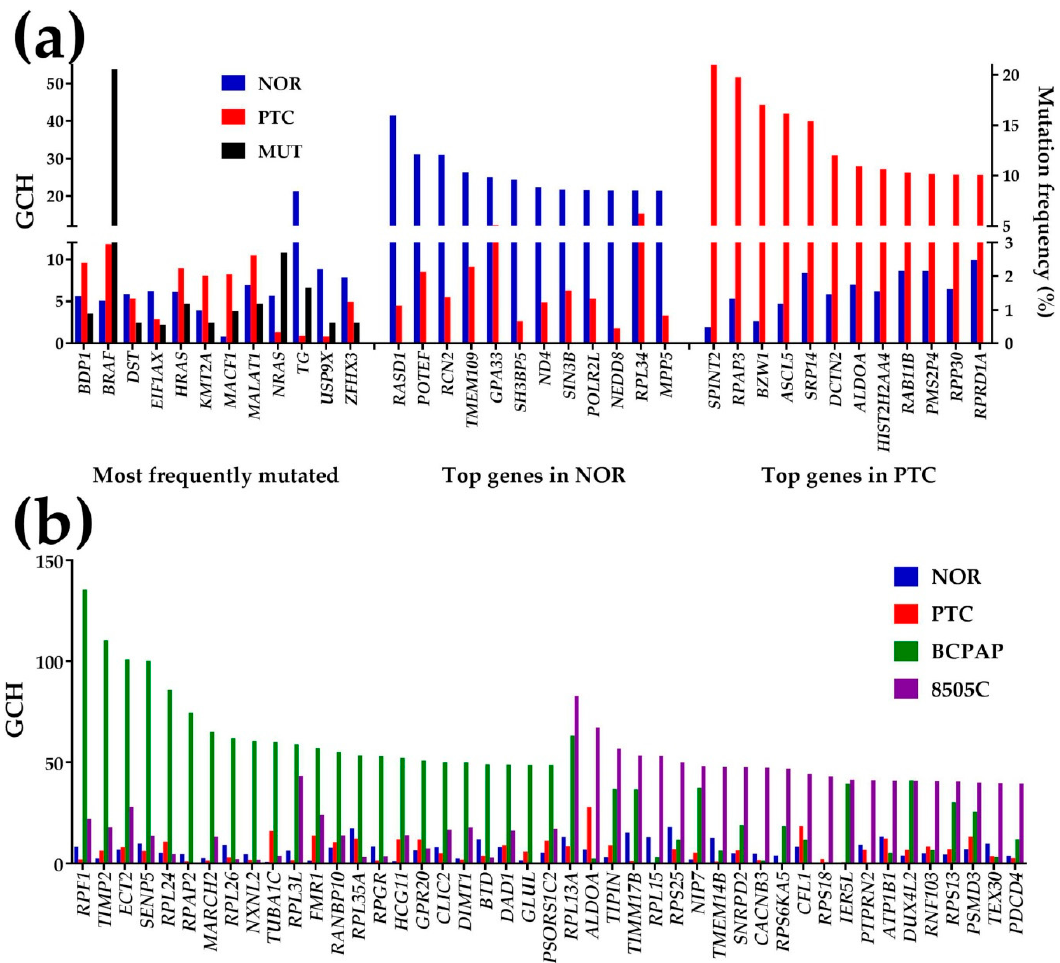
Figure 6. Gene Commanding Height (GCH). ( a ) GCH and mutation frequency of the 12 reported most frequently mutated genes and the top 12 genes in the normal tissue (NOR) and the papillary nodule (PTC). The mutation frequency is plotted on the right axis. ( b ) GCH of the top 23 genes in the papillary (BCPAP) and anaplastic (8505C) thyroid cancer cell lines and their scores in NOR and PTC. Top 3 genes in NOR: RAS, dexamethasone-induced 1 ( RASD1 ), POTE ankyrin domain family, member F ( POTEF ), reticulocalbin 2, EF-hand calcium binding domain ( RCN2 ). Top 3 genes in PTC: serine peptidase inhibitor, Kunitz type, 2 ( SPINT2 ), RNA polymerase II associated protein 3 ( RPAP3 ), basic leucine zipper and W2 domains 1 ( BZW1 ). Top 3 genes in BCPAP cells: ribosome production factor 1 homolog (S. cerevisiae) ( RPF1 ), TIMP metallopeptidase inhibitor 2 ( TIMP2 ), epithelial cell transforming 2 ( ECT2 ). Top 3 genes in 8505C cells: ribosomal protein L13a ( RPL13A ), aldolase A, fructose-bisphosphate ( ALDOA ), TIMELESS interacting protein ( TIPIN ).